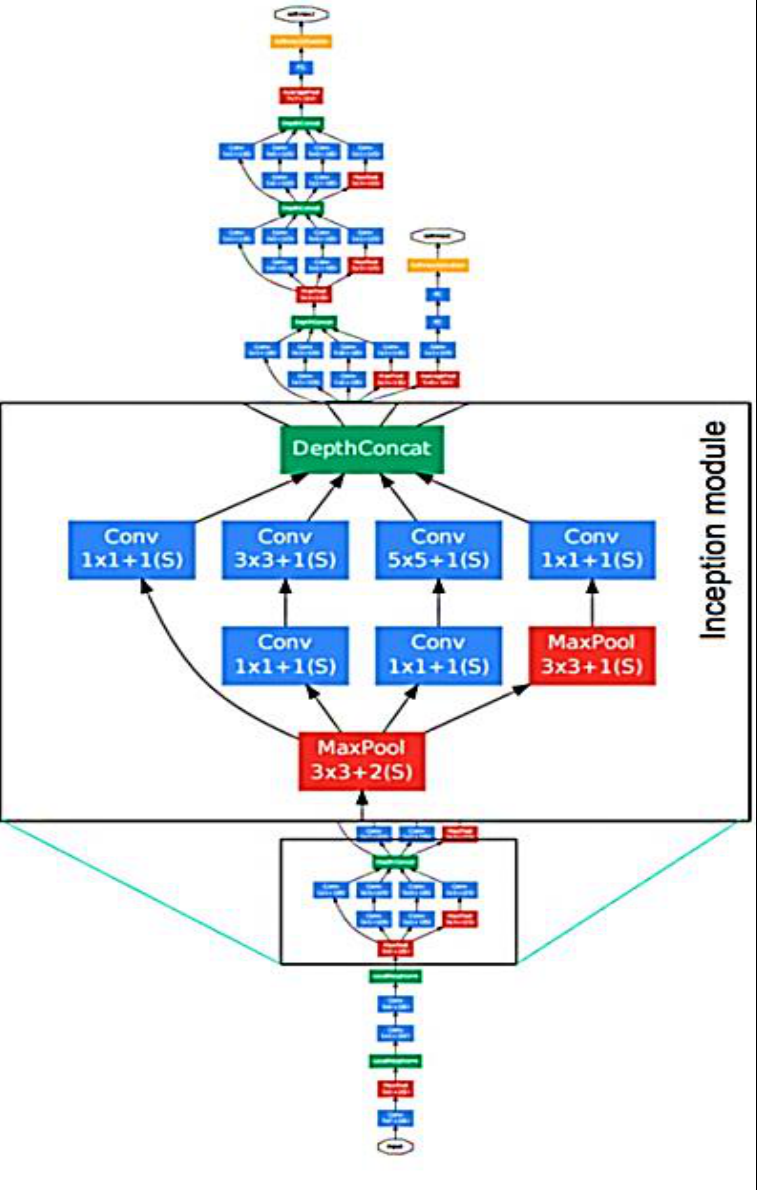
Figure 3: GoogleNet